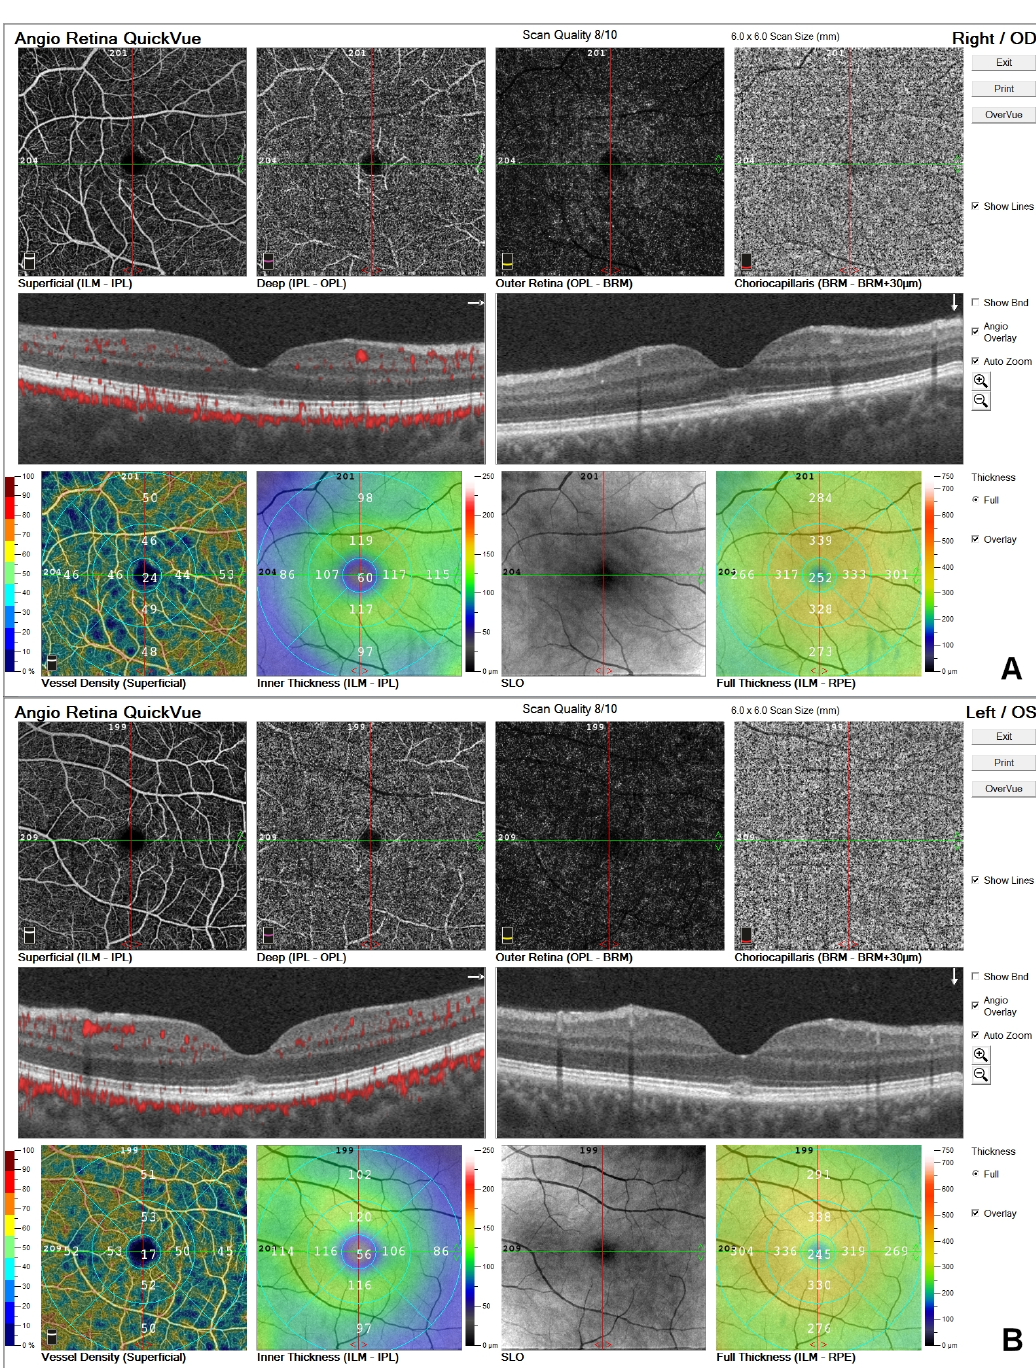
Figure 3: OCTA was normal; A) OD, B)